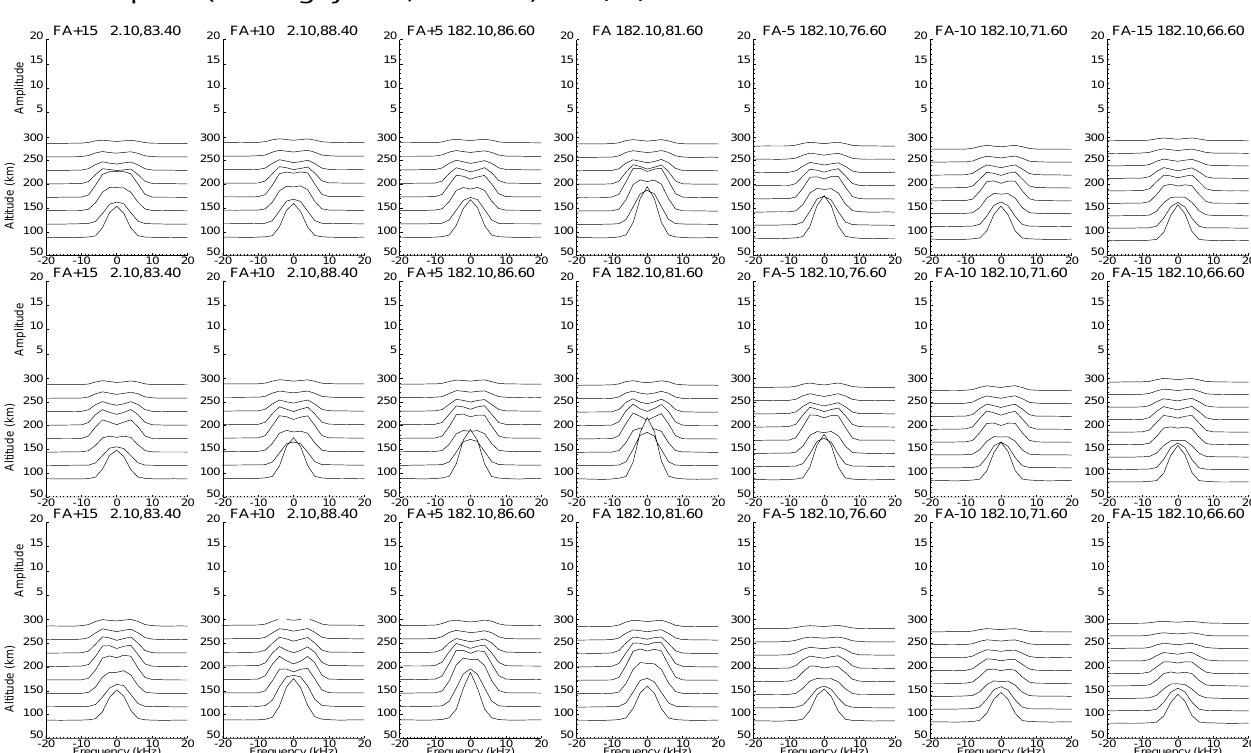
Fig. 9. Ion line spectra from scanning cycles 7, 11 and 14 from interval 2. The data are displayed using the same format and labelling as that applied in Fig. 7. These data contain fewer examples of F-region enhancements, although they appear to show enhancements in the E-region from FA+10, FA+5, FA and FA −